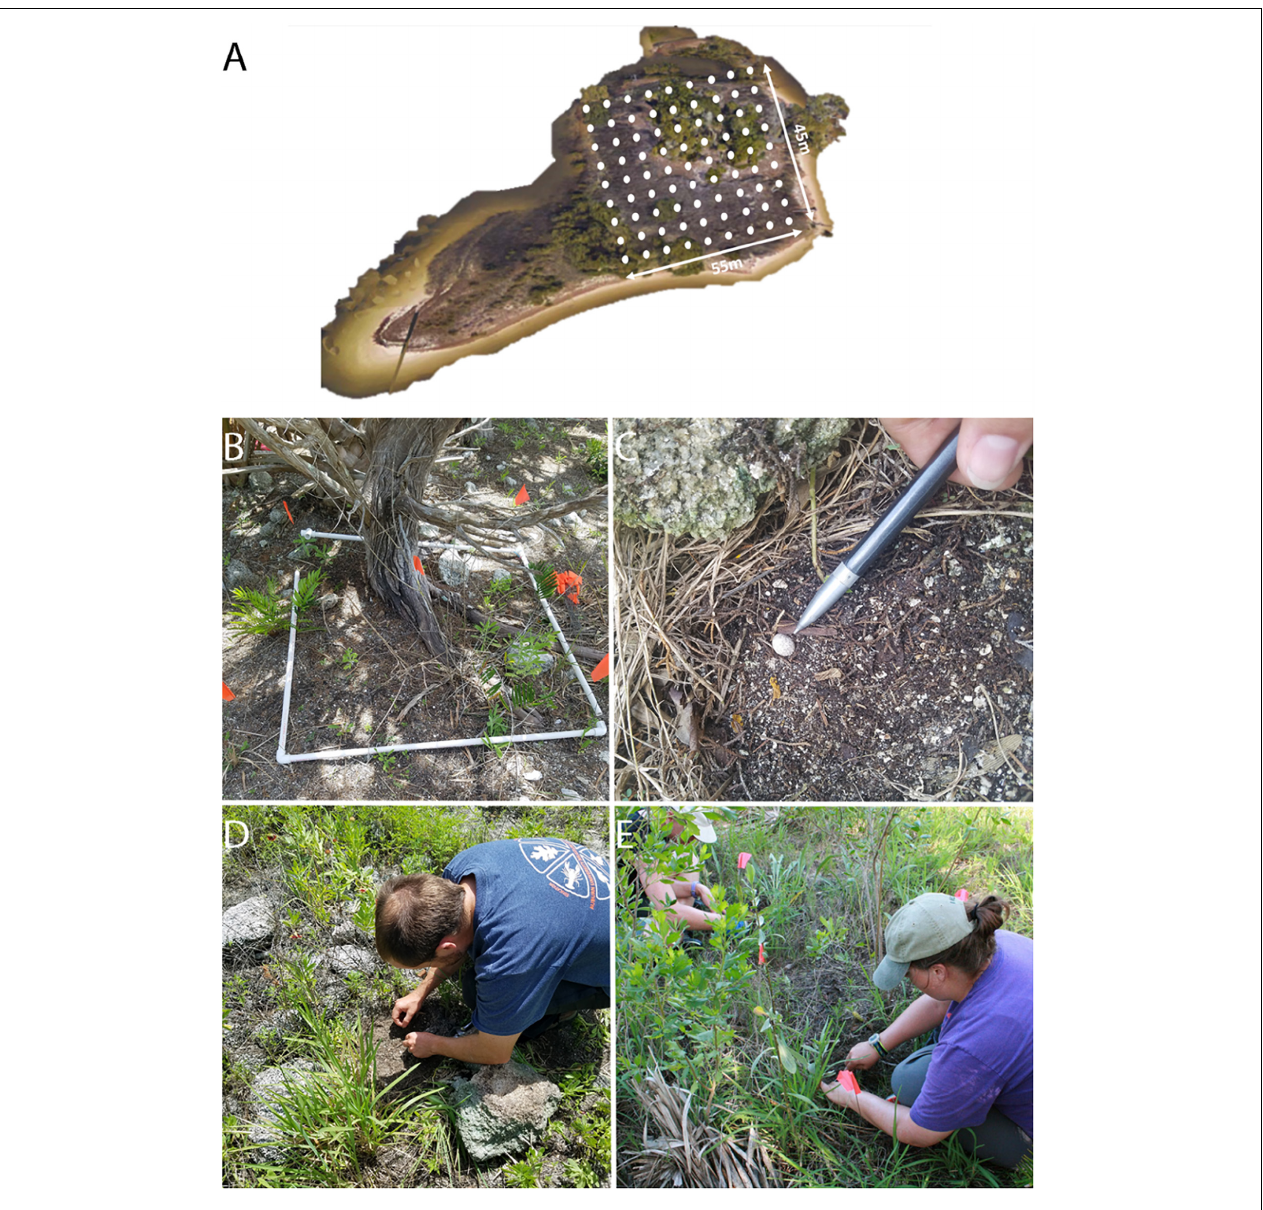
FIGURE 2 | (A) An aerial view of the spoil island used for studying nesting behavior. Each white dot represents a stake in the grid system. (B–E) Photos from the island field site where we searched for anole nests. The 1 m 2 quadrat that we used for searching (B) , a brown anole egg found under a rock (C) , a targeted search being conducted under rocks (D) , and a random search being conducted in dense vegetation (E) .